Question: Condense the content of this figure into a single sentence.
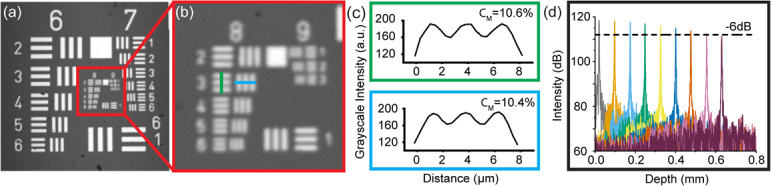
Answer: OCM performance characterization: (a) OCM en face projection of a USAF resolution target. (b) Magnified view of the resolution target image. (c) Line profile crosses the bars of Group 8 Element 3 with corresponding Michelson contrast values. (d) Sensitivity fall-off as a function of imaging depth.